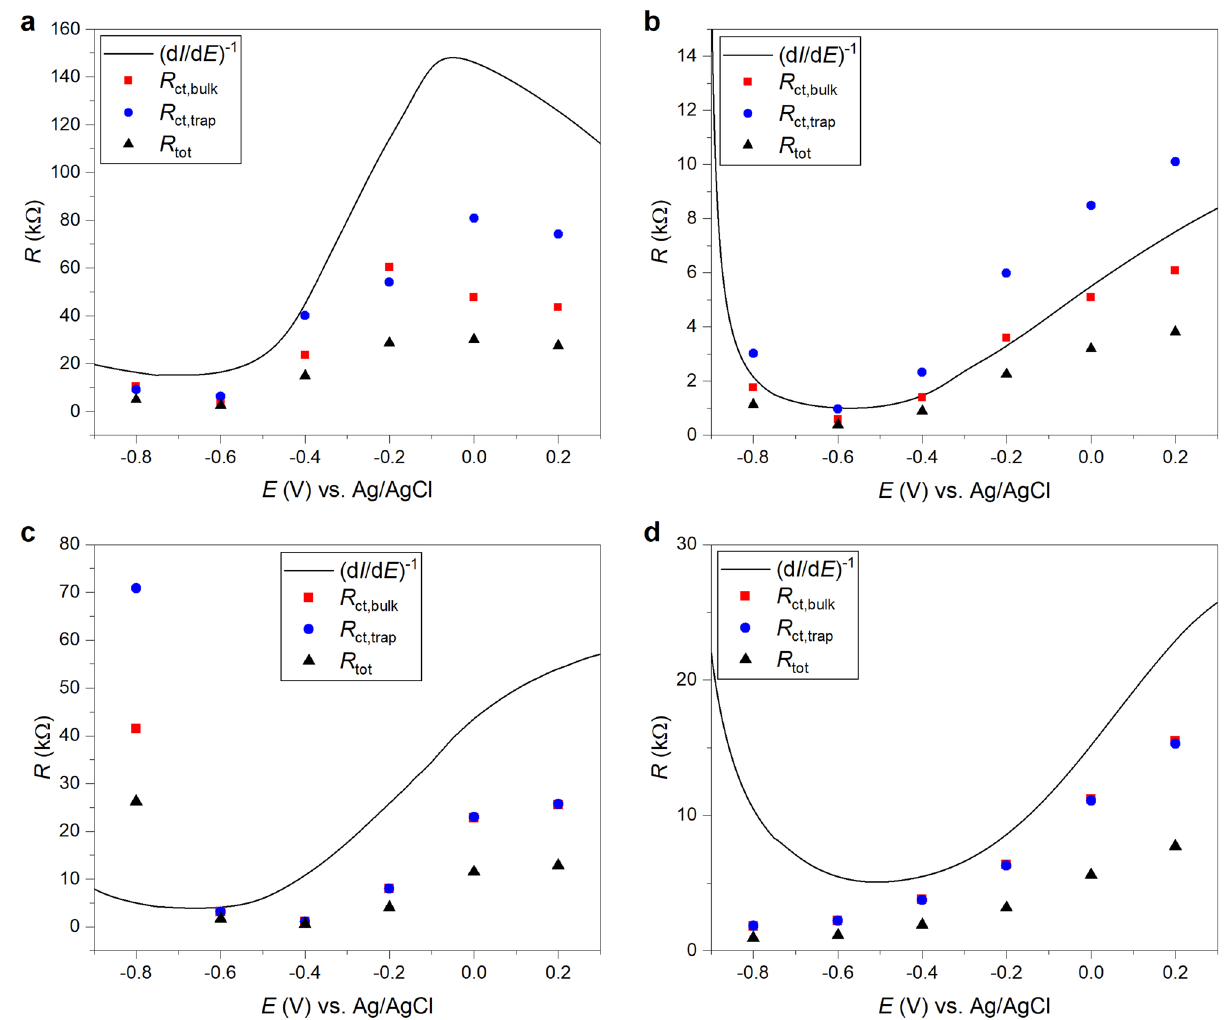
Figure 9. Comparison of resistances obtained by the derivation of linear sweep voltammetry curves after potential E with resistances deduced from Nyquist PEIS plots for TiO 2 nanolayers annealed at ( a ) 300 ◦ C , ( b ) 400 ◦ C , ( c ) 500 ◦ C , and ( d ) 600 ◦ C